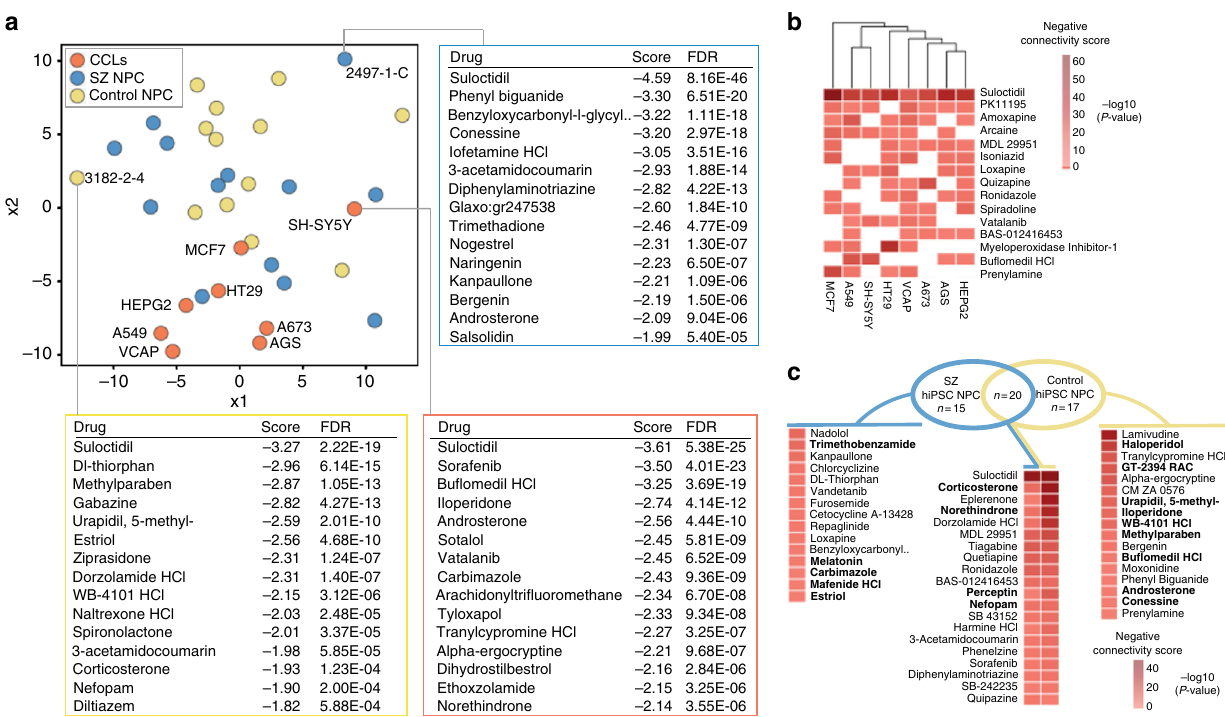
Fig. 3 Ability of drug-induced responses to reverse a SZ-related transcriptional signature. a Multi-dimensional scaling plot of individual cell lines based on connectivity scores between drugs and SZ post-mortem differentially expressed (DE) genes 23 . Top 15 drugs predicted to normalize SZ post-mortem DE genes, for representative control and SZ hiPSC NPCs, as well as the neuroendocrine derived CCL, SH-SY5Y. b Top 15 drugs sorted according to predicted ability to normalize SZ post-mortem DE genes across multiple CCLs. c Summary of drugs predicted to normalize SZ post-mortem DE genes in hiPSC NPCs, based on negative connectivity with aggregated SZ and control hiPSC NPC experiments. Heatmap cells with negative connectivity score corresponding to FDR < 0.1 are indicated. Highlighted in bold are the 18 drugs (5/15 SZ-speci fi c, 9/17 control-speci fi c, and 4/20 non-speci fi cally in hiPSC NPCs) that